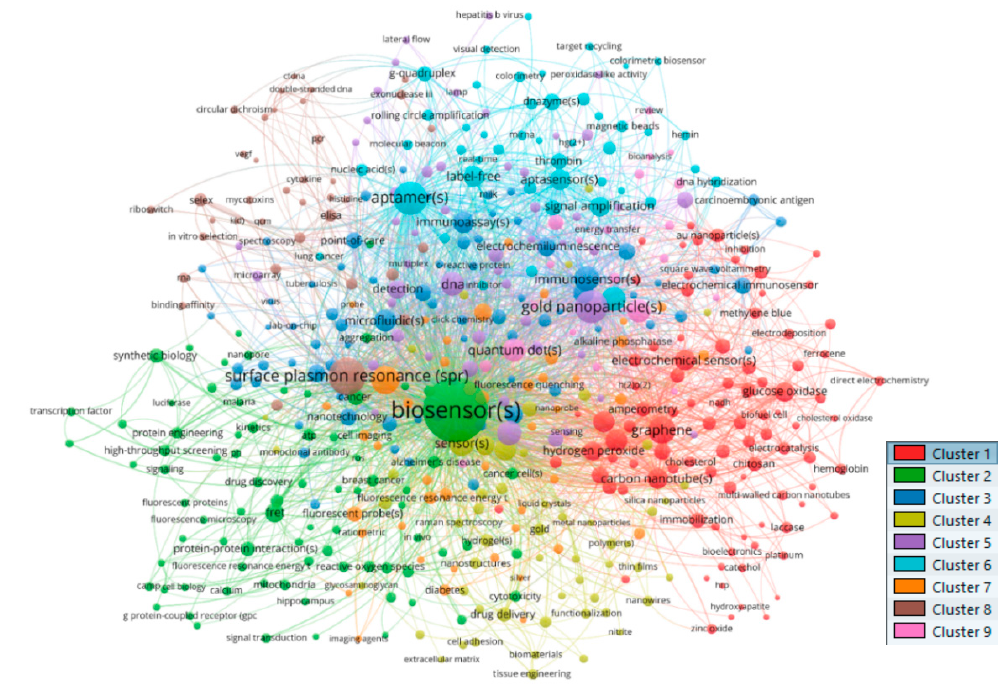
Figure 22. Co-occurrence analysis of Other Terms (or Author Keywords). Table 8. The top 20 most frequent Other Terms in each of the clusters depicted in Figure 22. Grey shades are added to rows to improve readability.